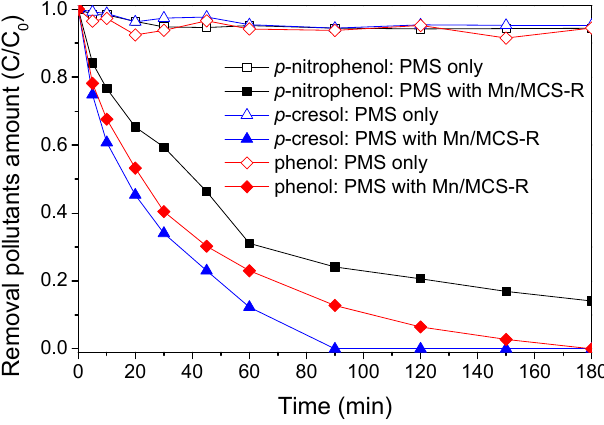
Figure 12. Effects of electron withdrawing group (EWG) and electron donating group (EDG) on degradation efficiency. Reaction conditions: [ p ‐ nitrophenol] 0 = 20 mg/L, [phenol] 0 = 50 ppm, [ p ‐ cresol] 0 = 20 ppm, [ p ‐ chlorophenol] 0 = 50 ppm, catalyst loading = 0.2 g/L, PMS loading: 2 g/L, temperature: 25 °C.